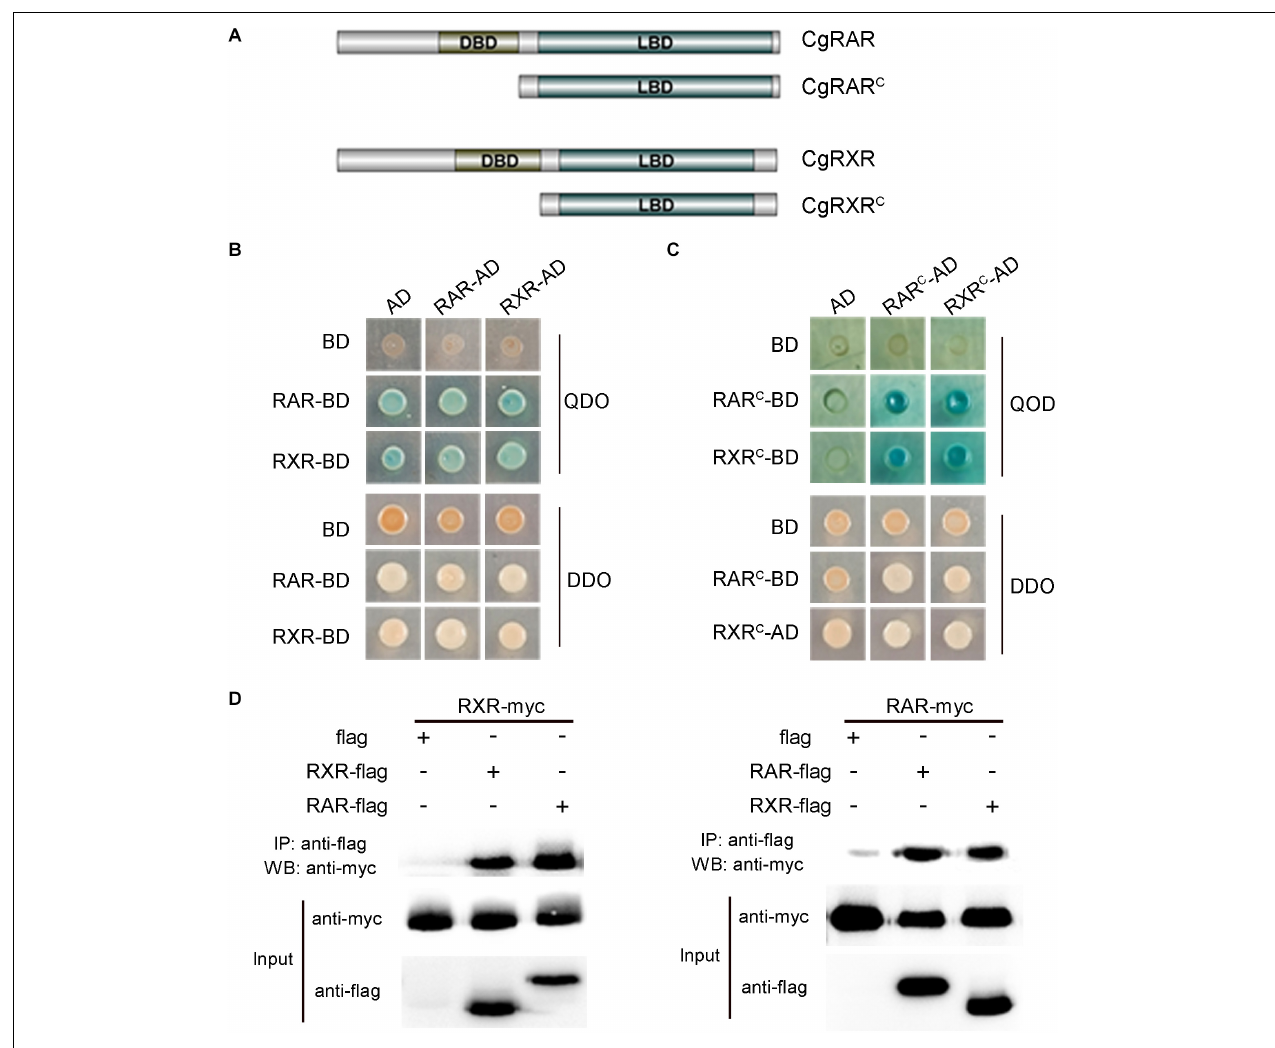
FIGURE 3 | CgRAR physically interacts with CgRXR. (A) Representation of truncated CgRAR and CgRXR proteins. (B) Yeast two-hybrid assay for interactions between CgRAR and CgRXR protein. (C) Yeast two-hybrid assay for interactions between truncated CgRAR and CgRXR protein. AD and BD empty vectors were co-transformed as negative control. QDO/X/A, quadruple drop-out medium to test interaction; DDO, double drop-out as control. QDO, SD/-Trp/-Leu/-His/-Ade; DDO, SD-Leu-Trp; X, X- α -gal; A, aureobasidin A (AbA). (D) Co-immunoprecipitation assays verified the interaction between CgRAR and CgRXR protein. WB analysis using anti-myc and anti-flag on total protein extracts (“Input”) and on eluted proteins after immunoprecipitation (IP) with anti-flag magnetic